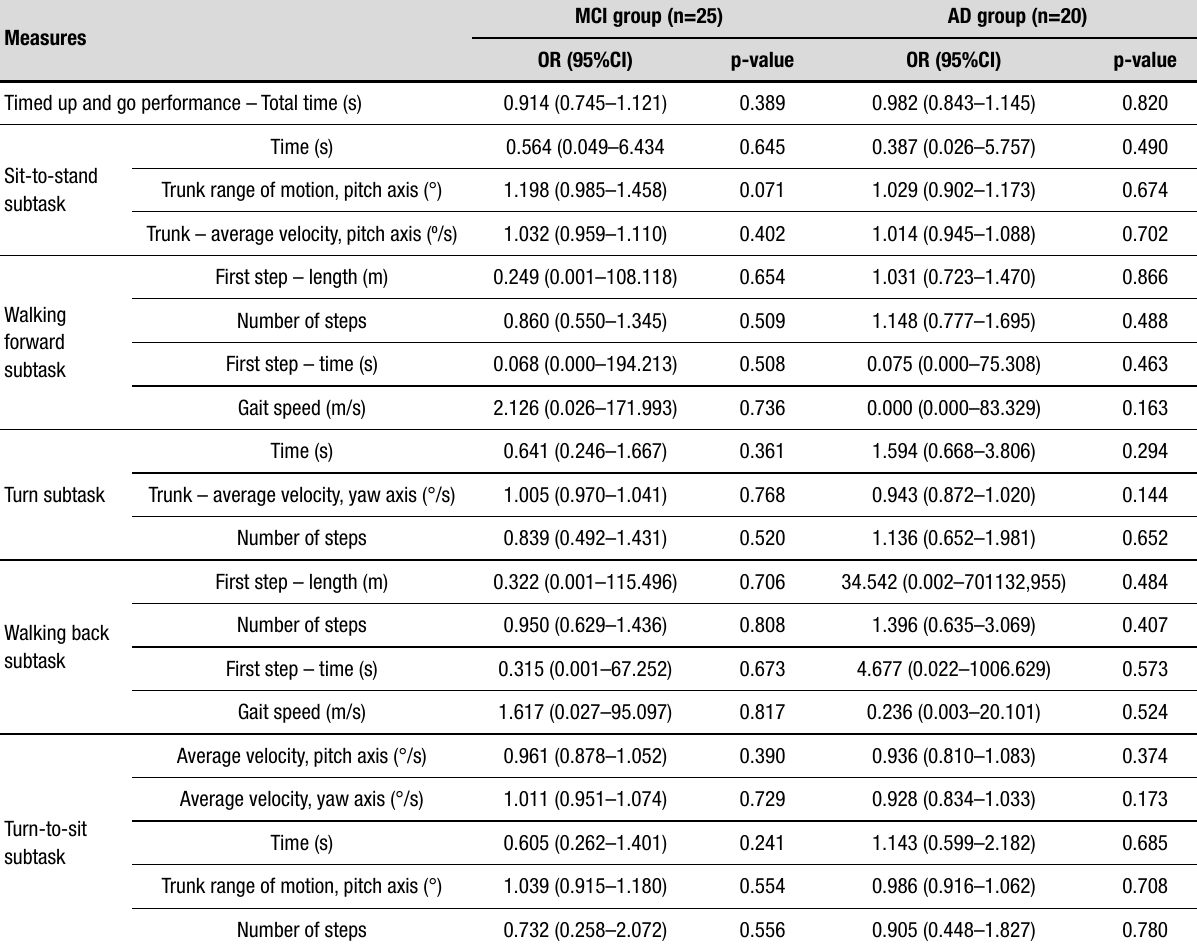
Table 3. Univariate mobility predictors of functional decline in participants with mild cognitive impairment and Alzheimer’s disease, by the logistic regression